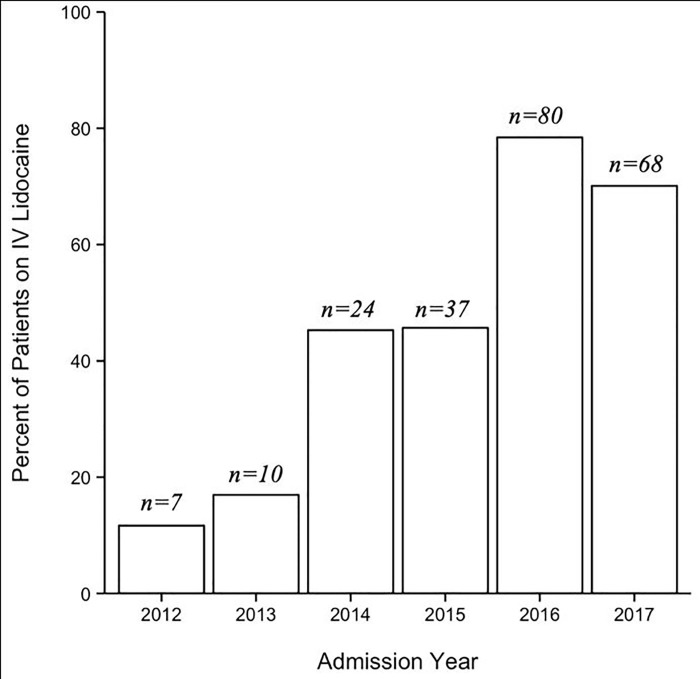
Increase in intravenous lidocaine use over the study period.